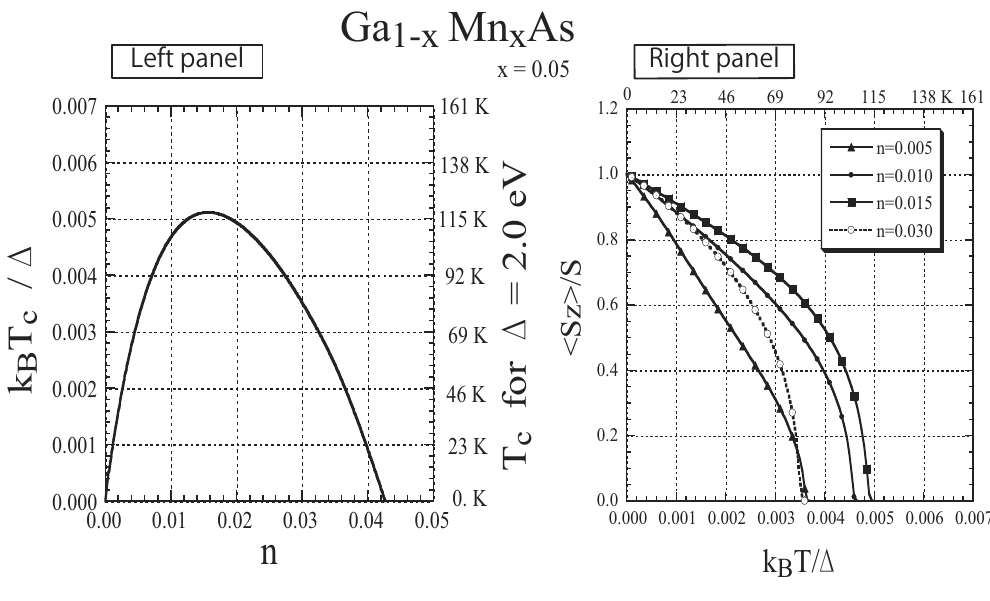
Figure 15. The results for Ga Mn As with x = 0 : 05 . Left panel: Curie 1 − x x temperature T as a function of n . Right panel: Magnetization as a function of c the temperature T for various values of n . From Takahashi and Kubo [42] and Takahashi et al.